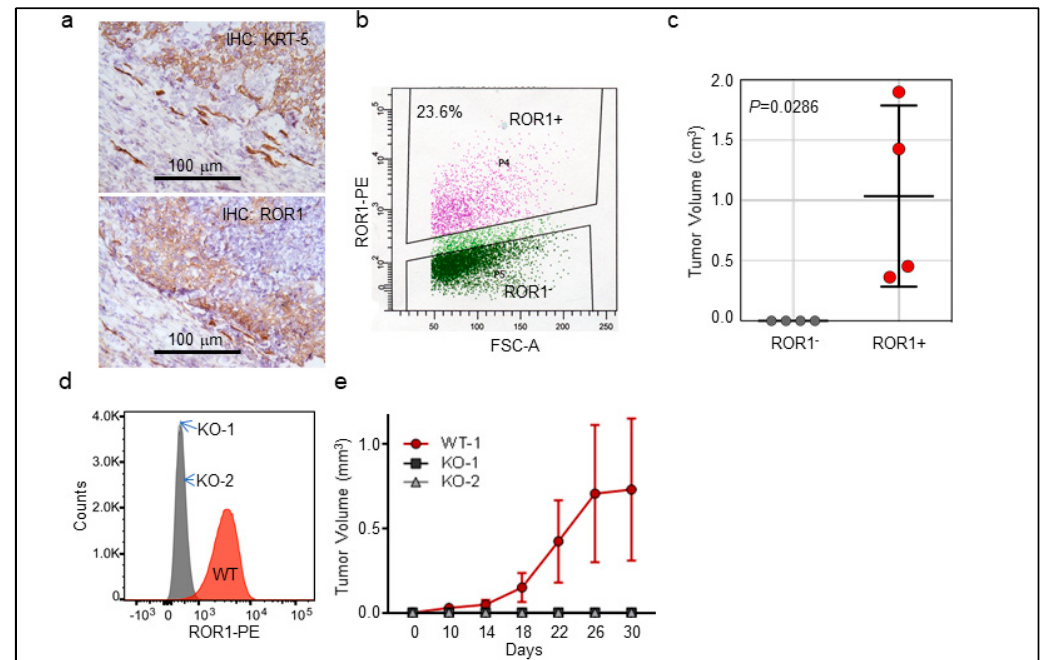
Figure 2. ROR1 + cells are tumorigenic. ( a–c ) One clinical TNBC specimen was stained with cytokeratin-5 (KRT-5) for defining basal cancer type and with ROR1 for its positivity ( a ). A fresh TNBC with confirmed basal type was digested into single cell suspensions, following with flow cytometry to separate into ROR1 + and ROR1 − epithelial (labeled by EpCAM+) populations ( b ). 5000 ROR1 + or ROR1 - TNBC cells were orthotopically injected into 7-week old immunodeficient female NSG mice for tumor growth, with one #4 fatpad injected with ROR1 + and the other #4 fatpad with ROR1 − cells for stringent comparison. Tumors were monitored ( c , shown as mean ± SD, n = 4). ( d , e ) CRISPR/Cas9-mediated KO of ROR1 in MDA-MB-231 cells with two clones shown as negative of surface ROR1 staining by flow cytometry ( d ) and 2 million of WT and KO MDA-MB-231 cells were injected into #4 fatpad of NSG mice and tumor growth were measured ( e , shown as mean ± SD, n = 7–8, p < 0.001, 2-way ANOVA).